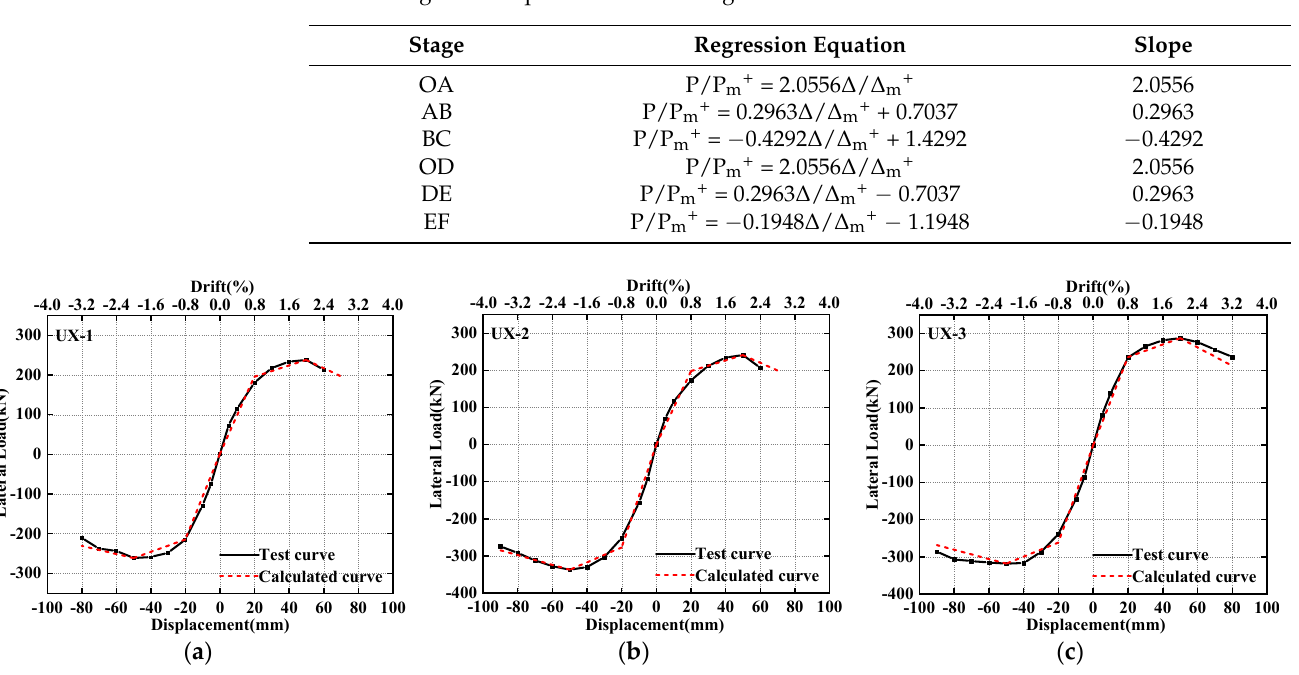
Table 4. Regression equations for each stage of the skeleton curve model.